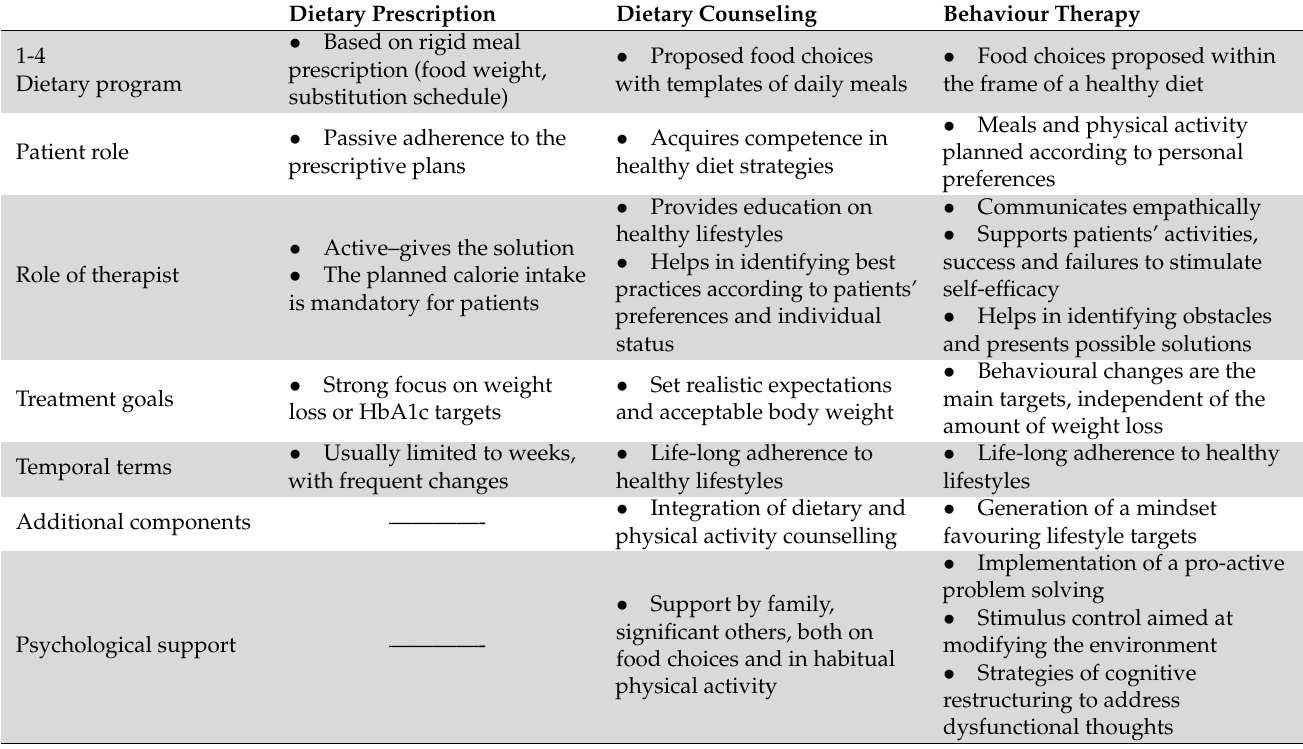
Table 1. Comparison of strategies and goals of different dietary